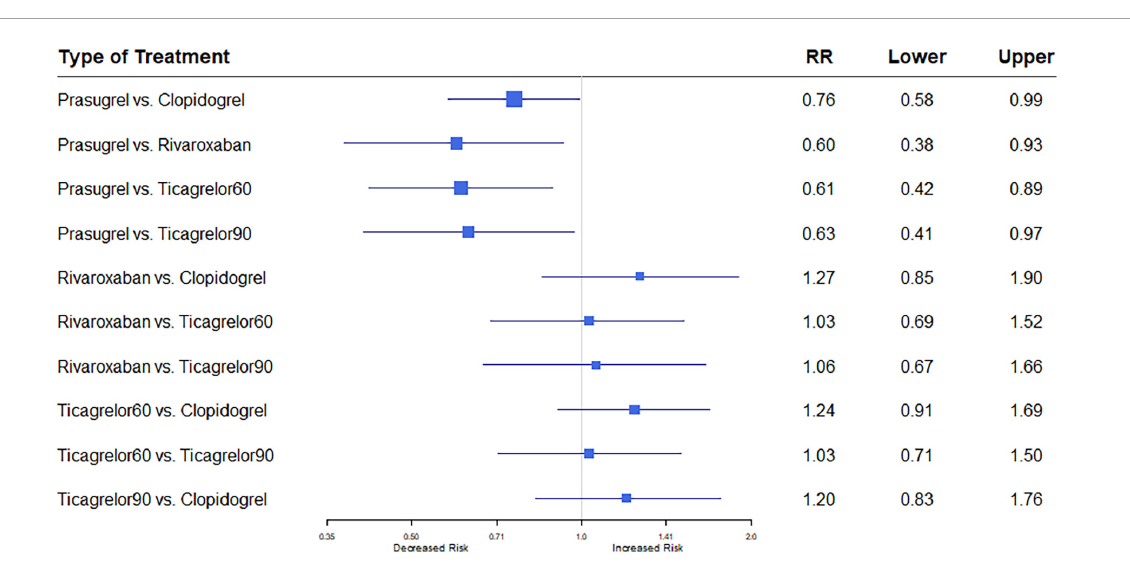
FIGURE4 A network meta-analysis of the association between anti-thrombotic therapy and myocardial infarction in patients with chronic coronary syndrome. Net-work Meta-analysis of the Association Between anti-thrombotic therapy and MI. The size of squares is proportional to the weight of each study. Horizontal lines indicate the 95% CI of each treatment; diamond, the pooled estimate with 95% CI; and RR, relative